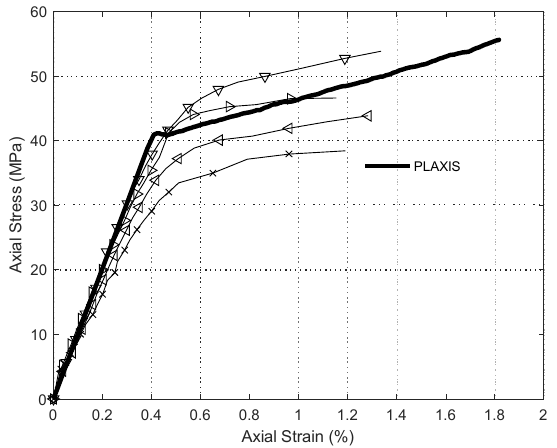
Figure 2. Comparison between the FEM model results and the experimental data from four different 40 MPa standard 150 mm × 300 mm concrete cylinders with one fiber reinforced plastics (FRP) wrap each.